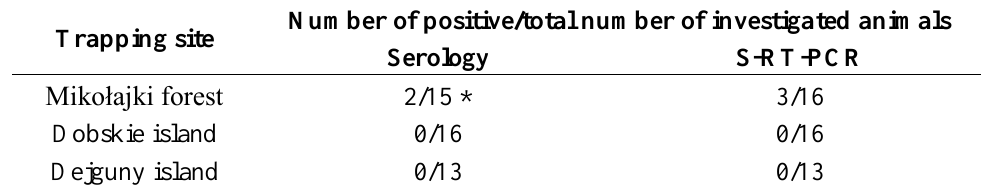
Table 1. Results of the serological and S segment RT-PCR investigations of bank voles trapped at three sites in